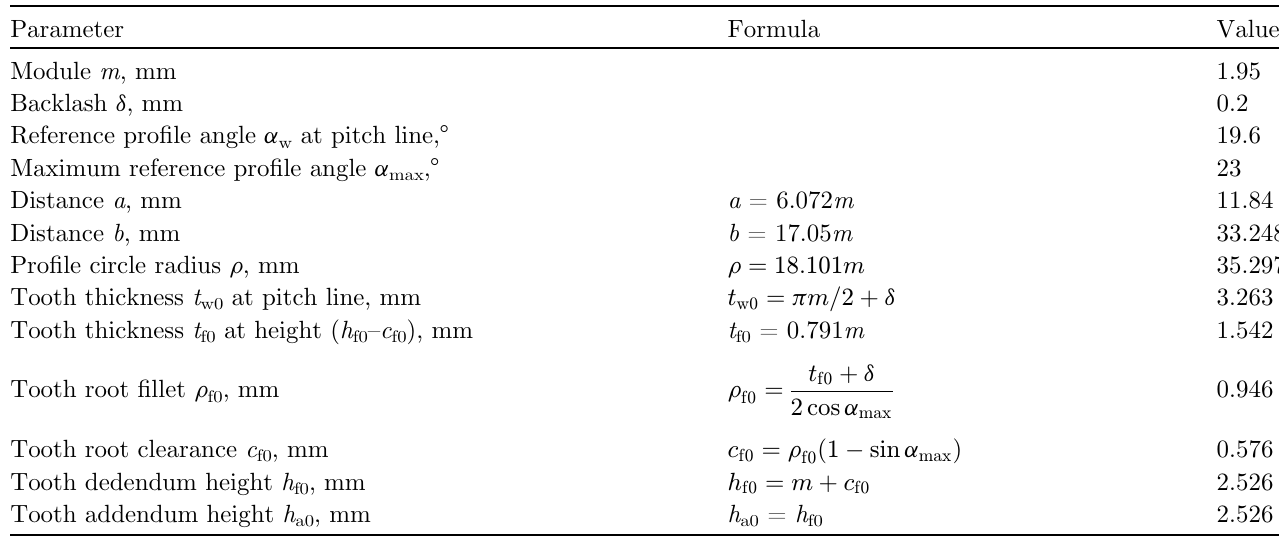
Table 5. Reference pro fi le parameters.